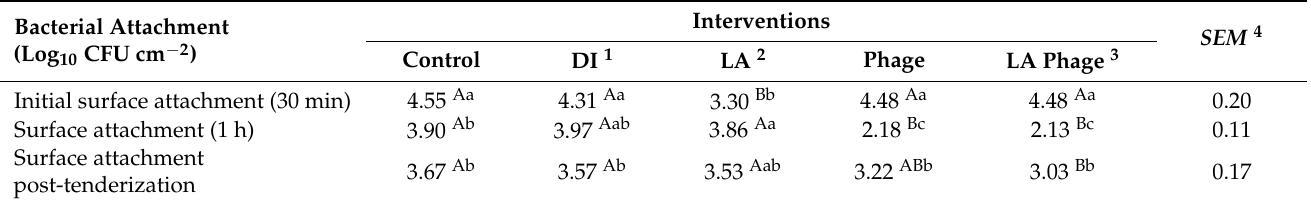
Table 2. The influence of lactic acid (2.5%), lytic bacteriophage (5%), and a combination of both on the surfaces of marinated and manually tenderized pork loins inoculated with Salmonella spp. Bacterial Attachment (Log 10 CFU cm − 2